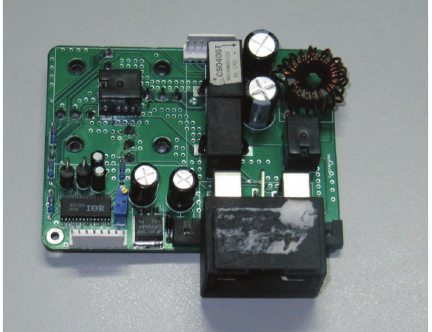
Figure 3: Assistant motor in the test.